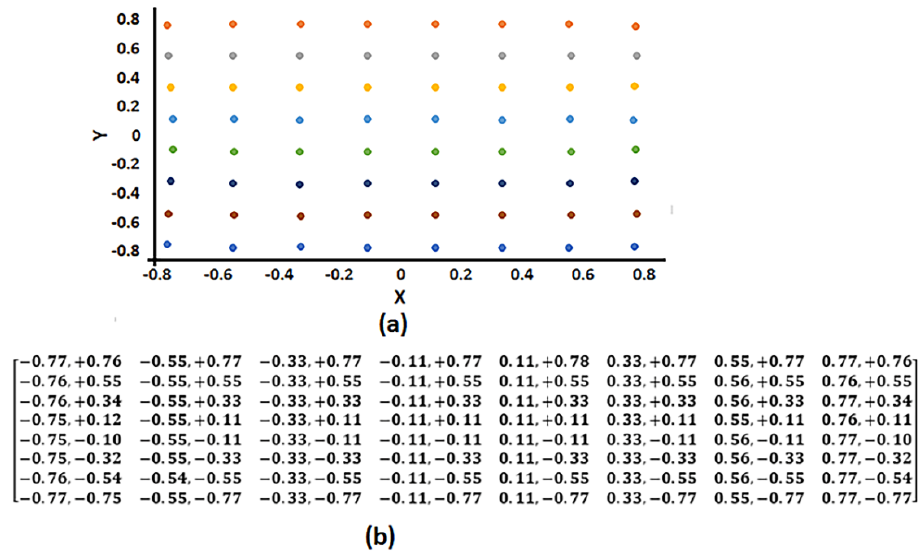
Figure 13. Position verification of the readout circuit. ( a ) position of the input current pulse applied mutual exclusively. ( b ) Computed position coordinates that correspond to the individual input current pulse.